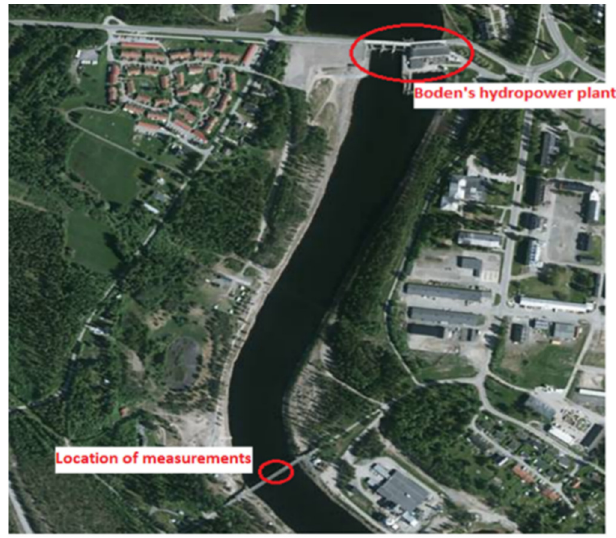
Figure 2. Location of the field measurement campaign—Svedjebron, Boden, Sweden (Google maps). The same cameras and synchronization were used for the river flow measurements.